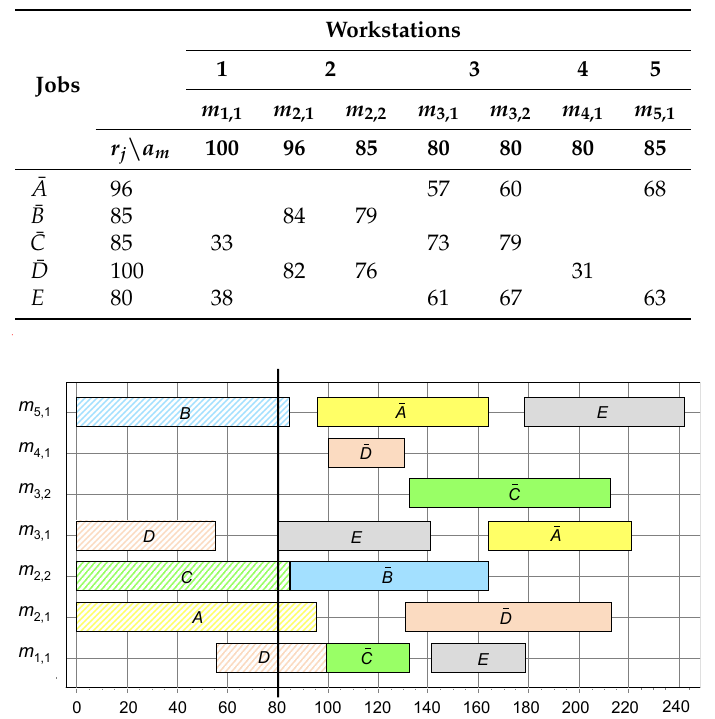
Figure 1. Optimal Pareto front and the Gantt charts of the corresponding schedules for the demonstrative example. Table 2. Data for the rescheduling example after introducing job E at time 80 in the demonstrative example starting with Schedule #2 in Figure 1.